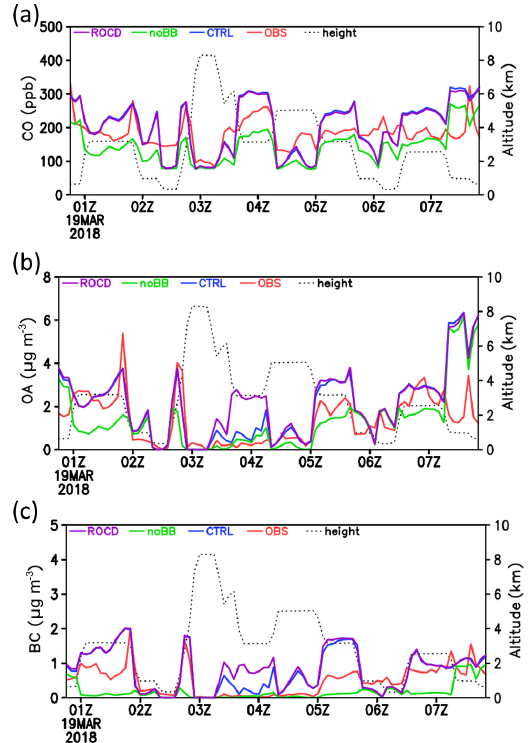
Figure 10. Observed (OBS, red) and simulated concentrations (CTRL, blue) and the simulation without indirect effect (ROCD, purple), without BB emission (noBB, green) along with the flight altitude for (a) CO (ppb), (b) OA (µgm − 3 ), and (c) BC (µgm − 3 ) on 19 March